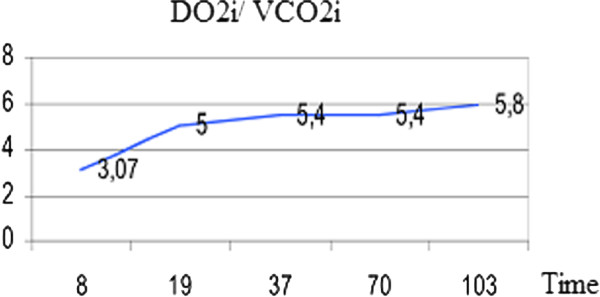
Oxygen Delivery/Carbon Dioxide Production: (DO2/VCO2).